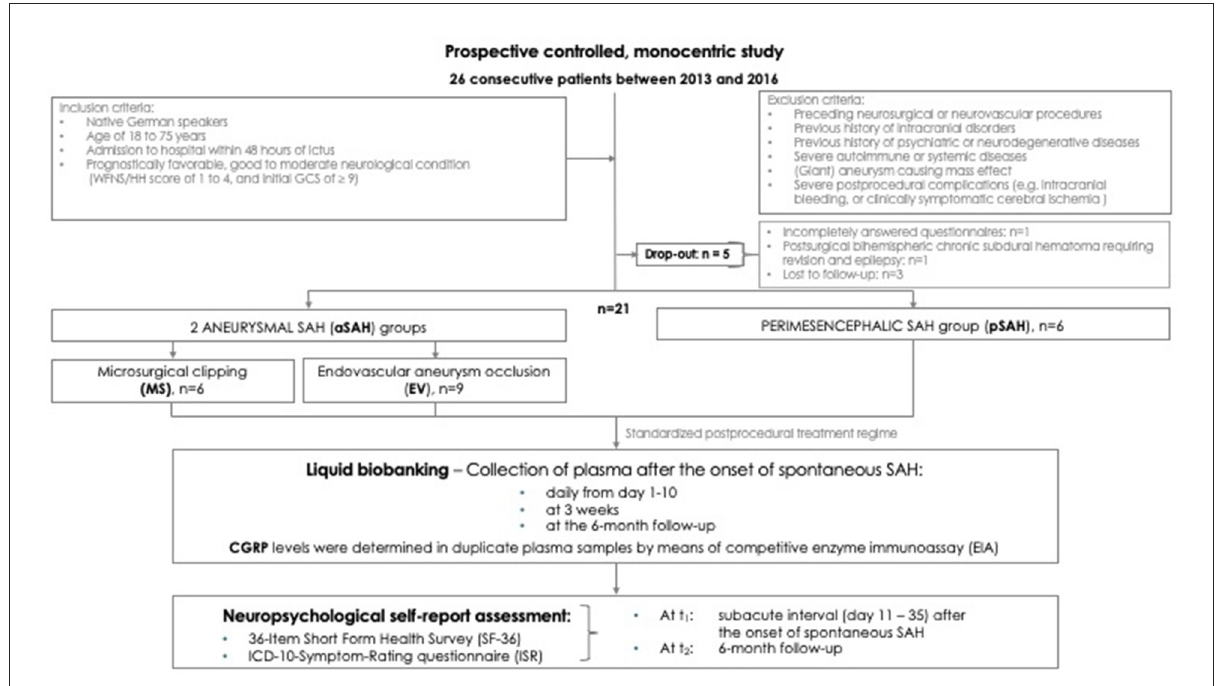
FIGURE1 Flowchart. Study design and reasons for exclusion of potentially eligible